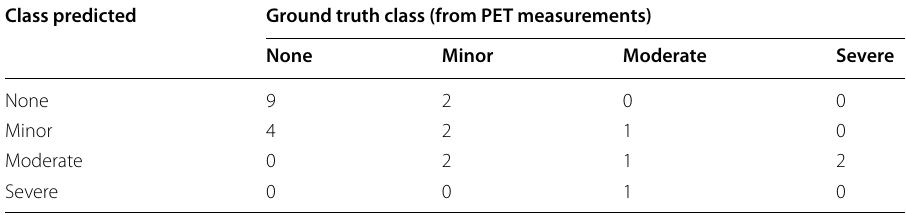
Table 2 Multiclass confusion matrix of extravasation severity for the radiological analysis Class predicted Ground truth class (from PET measurements) None Minor Moderate Severe